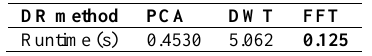
Table 4. Runtime of DR methods applied to Img-III.